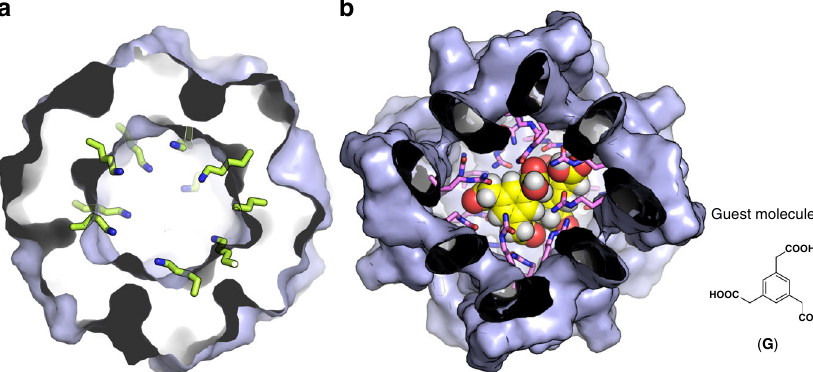
Fig. 6 Inner modi fi cation and guest encapsulation within the [6]catenane framework. a Estimated model of the side chain positions at the Z residue using ligand 5K as an example. Lys side chains are highlighted in stick representation and the remaining [6]catenane framework (surface representation) is a cross-sectional view. Note that all of the Cbz protecting groups and some of the Lys side chains have been omitted for clarity. b Geometry-optimised structure of encapsulation complex [Ag 24 ( 9 ) 24 ] 24 + (cid:129) ( G ) 2 . The [6]catenane framework, all the side chains of Cit residues, and G are shown in surface, stick, and space- fi lling representations, respectively. The chemical structure of G is also